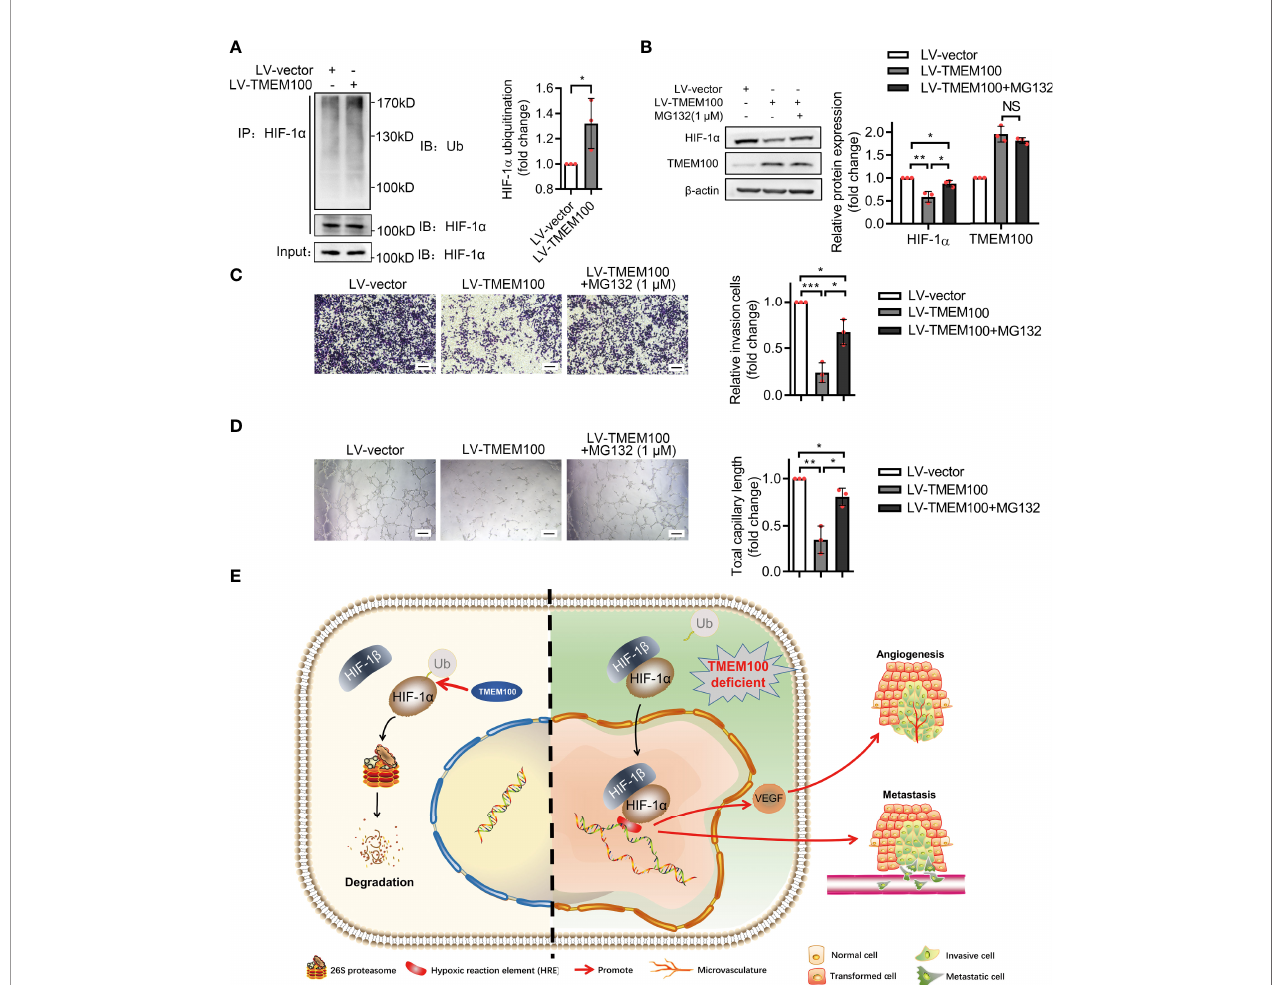
FIGURE 6 | TMEM100 inhibits the migration and angiogenesis induction capacities of CRC cells by promoting the degradation of HIF-1 a via ubiquitination/ proteasome pathway. (A) HCT116 cells were infected with LV-TMEM100 or LV-vector lentiviruses, and then cultured for 48 h under hypoxic conditions. Cell extracts were immunoprecipitated (IP) using anti-HIF-1 a antibody and blotted with anti-ubiquitin antibody. HIF-1 a was used as a reference control. Two-sided t-test. (B) All cells were grown in hypoxic environments for a total of 48 h. For cells in “ LV-TMEM100 + MG132 ” group, MG132 (1 m M) was supplemented to the medium. The cell lysates were then analyzed by western blotting. b -actin was used as a reference control. Two-sided t-test. (C) Transwell assays were performed to evaluate the migration capacities of cells in indicated groups under hypoxic conditions. Scale bar = 100 m m. Two-sided t-test. (D) The in vitro tube formation assays were performed to evaluate the angiogenesis induction capacity of HCT116 cells in indicated groups. Two-sided t-test. (E) The schematic representation of TMEM100 promoting HIF-1 a degradation via ubiquitination/proteasome pathway. HRE means hypoxia-response element. Data are presented as the mean ± SD. * p <0.05, ** p <0.01, *** p <0.001. NS, no signi fi